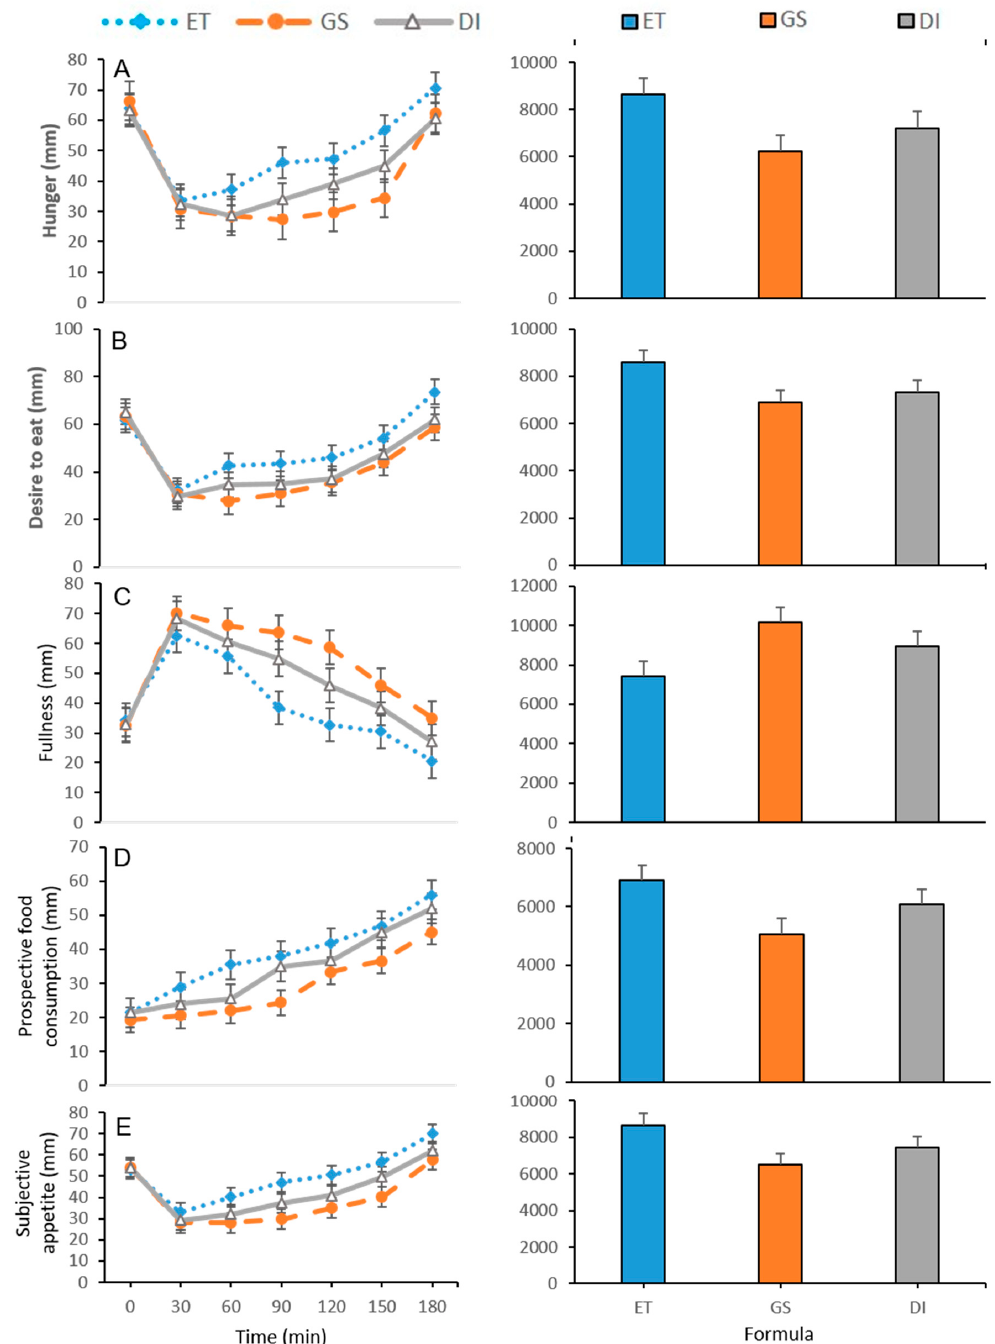
Figure 2. Time course and formula of postprandial perception of hunger, desire to eat, fullness, prospective food consumption, subjective appetite and AUC 0–180 min values following ingestions of GB, ET, GS and DI. ( A ) hunger in relation with time and formula; ( B ) desire to eat in relation with time and formula, ( C ) fullness in relation to time and formula, ( D ) prospective food consumption in relation with time and formula and ( E ) subjective appetite in relation with time and formula. Data are expressed as means ± SEM, ( n = 16). Data comparisons about di ff erences in subjective measurements of appetite according to consumption tests are described in Table 5. The same colour scheme was used for all graphs. All means of AUC 0–180 min showed significant di ff erences ( p < 0.02) in each group. Treatment groups: (ET) standard nutritional supplement not specifically for people with diabetes. (GS) Resistant maltodextrin and sucromalt supplement. (DI) Isomaltulose and resistant starch